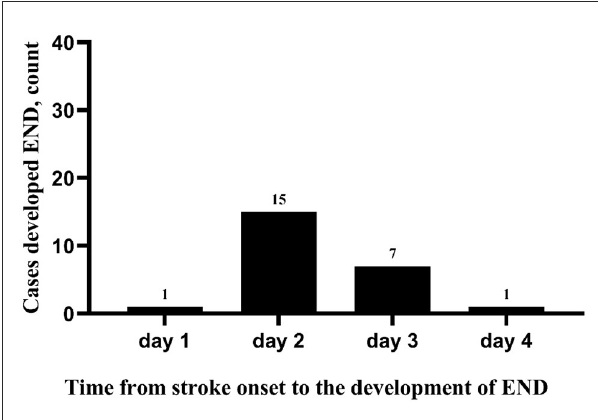
FIGURE2 Time from the stroke onset to the development of END.